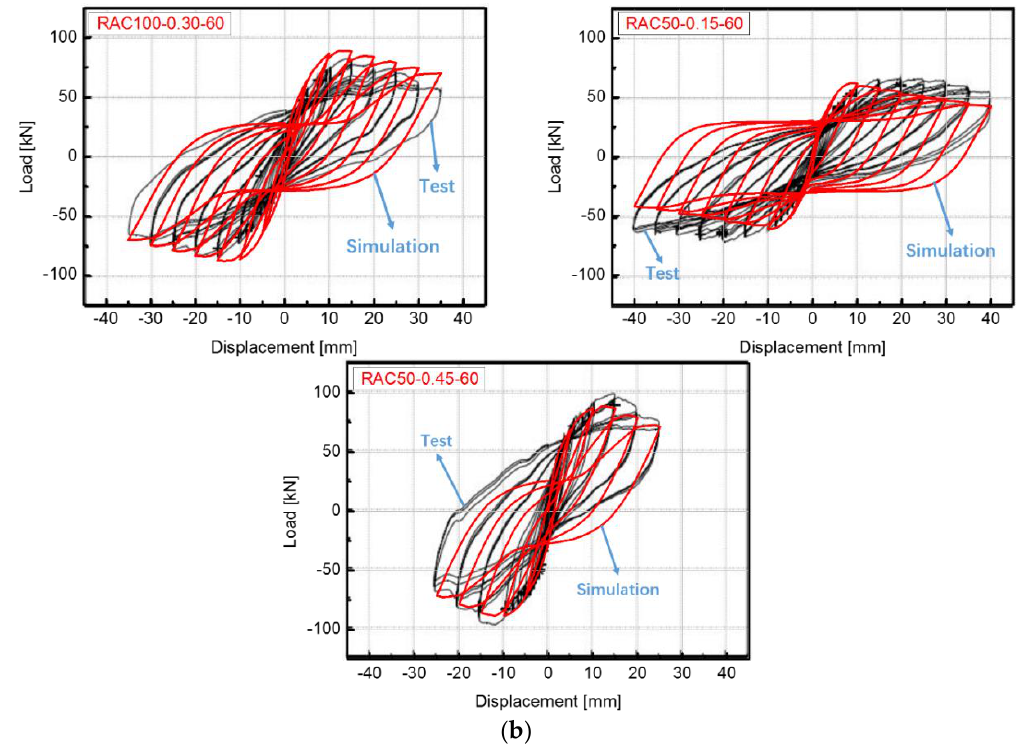
Figure 4. Comparison of hysteresis loops between experimental and numerical results. ( a ) Test specimens in Xiao et al. [42], and ( b ) test specimens in Yang [43].